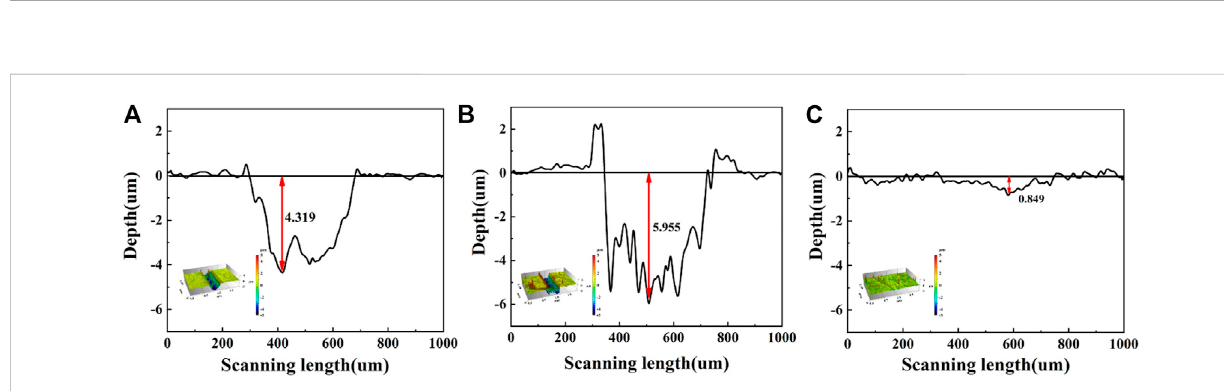
FIGURE 12 The cross-section pro fi les of the wear tracks of the PI substrates treated with different graphite target currents: (A) 0.0 A (B) 2.5 A (C) 3.0 A.